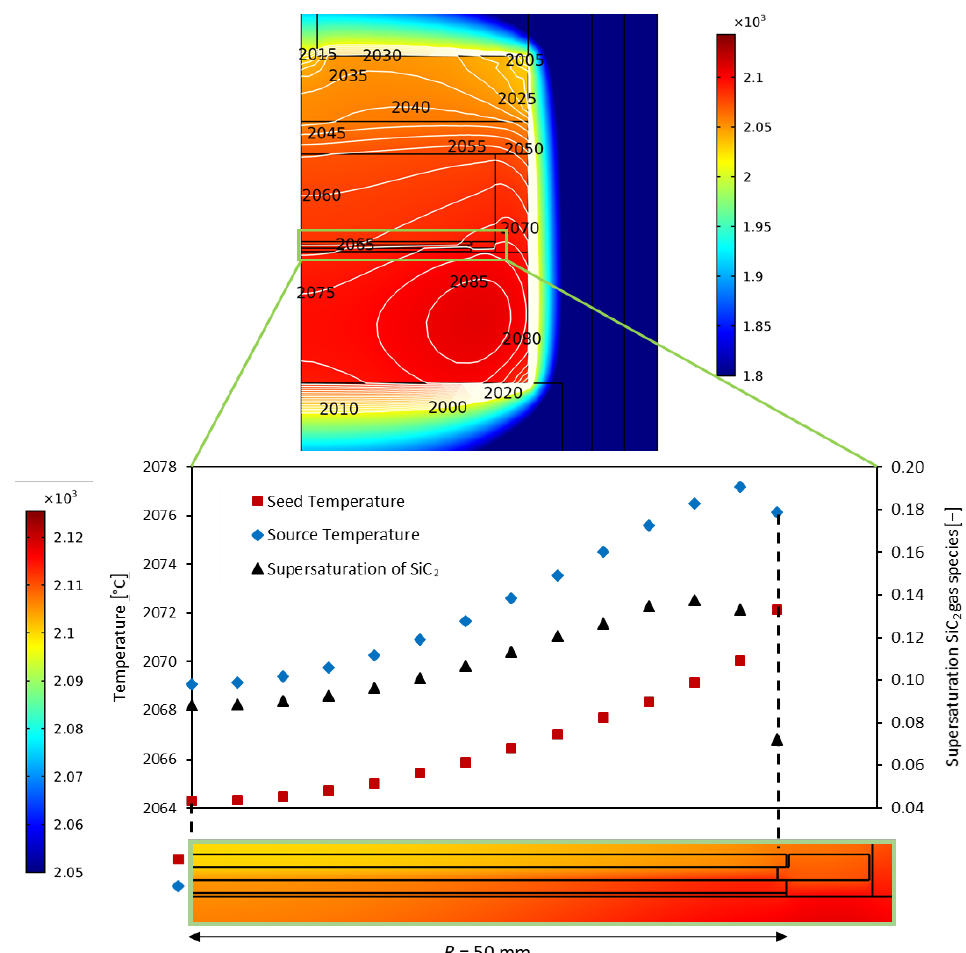
Figure 2. Simulation of the temperature field for an input power of 4.2 kW and calculation of the supersaturation in a vapor phase growth reactor for 100 mm 3C-SiC single crystals (the radius R is indicated in the bottom panel). The calculations of the supersaturation were based on the work of Avrov [34].